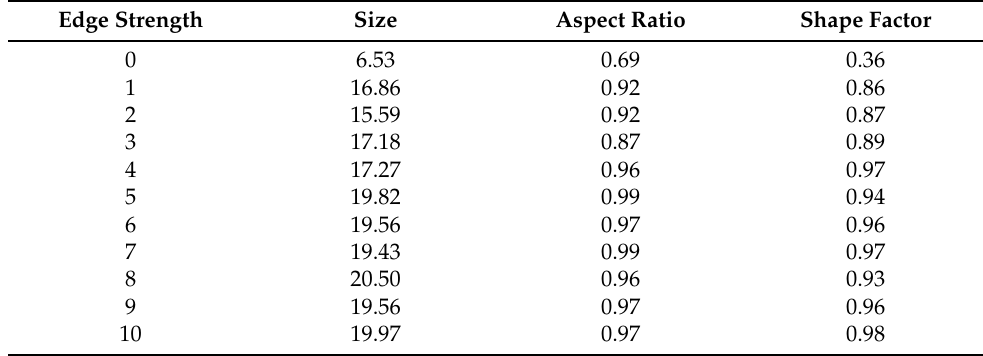
Table 3. Associated results to Figure 6, based on different ESVs.